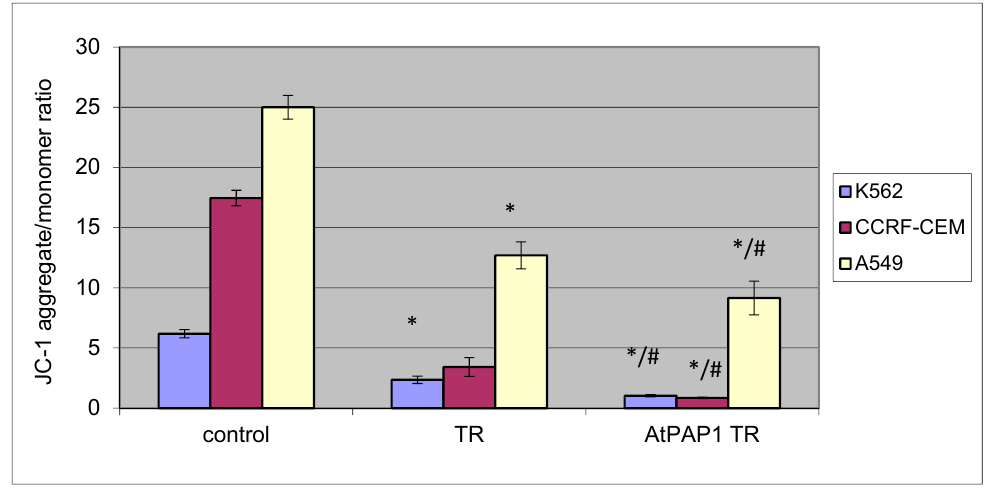
Figure 2. The effect of TR and AtPAP1 TR root extracts of L. sibiricus on mitochondrial membrane potential in CCRF-CEM, K562 and A549 cells. MMP is expressed as a ratio of 530 nm/590 nm to 485 nm/538 nm (aggregates to monomer) fluorescence, as quantified with a fluorescent plate reader after JC-1 staining. The data represent means ± standard deviation (SD). *: p < 0.05 Control vs. TR and AtPAP1 TR. #: p < 0.05 TR vs AtPAP1 TR.